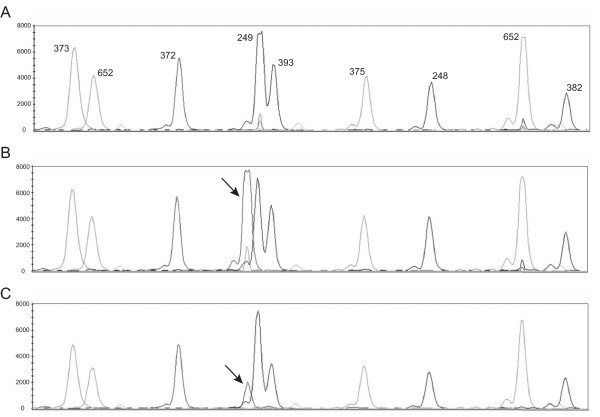
FGFR3 mutation detection on urinary derived DNA. FGFR3 mutation analysis of an FGFR3 tumor without a mutation (A), mutation S249C on tumor DNA (B) and urinary derived DNA (C) from the same patient used in panel B.